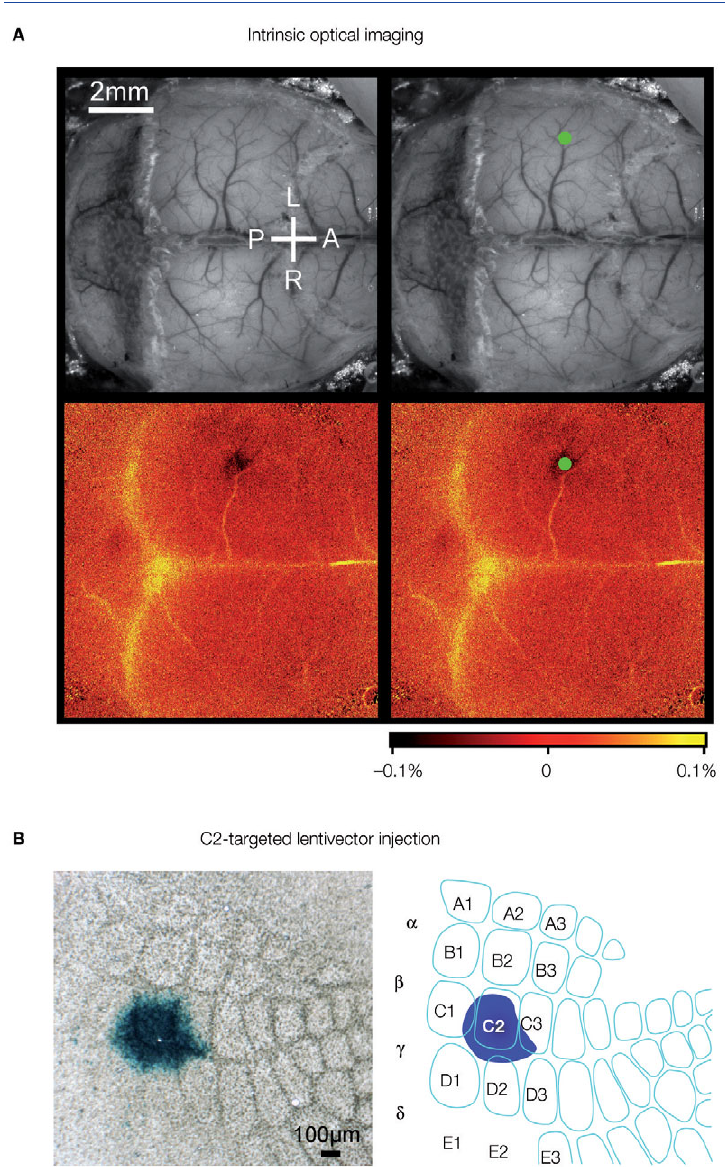
Figure 3 | Column specifi c genetic manipulation of the barrel cortex. (A) Intrinsic optical imaging through the intact mouse skull can be used to non-invasively map the neocortex. Defl ection of the C2 whisker evokes a localized hemodynamic signal highlighted by a green dot. The functional mapping can be related to the blood vessel layout allowing targeted crani- otomy and lentivector injection. (B) Injection of lentivector was targeted to the C2 barrel col- umn through intrinsic optical imaging. The lentivector expressed Cre recombinase and was injected into a ROSA26R Cre-reporter mouse, which expresses LacZ in the presence of Cre- activity. Modifi ed and reproduced with permission from Aronoff and Petersen (2007). Frontiers in Integrative Neuroscience